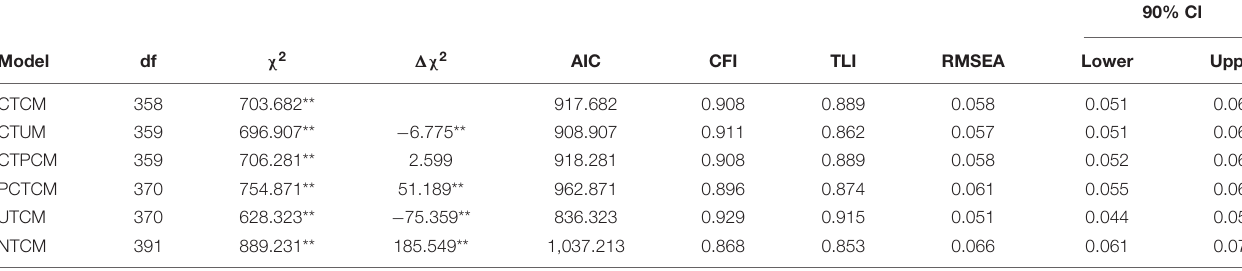
TABLE 4 | Fit indices for the multi-trait/multi-method